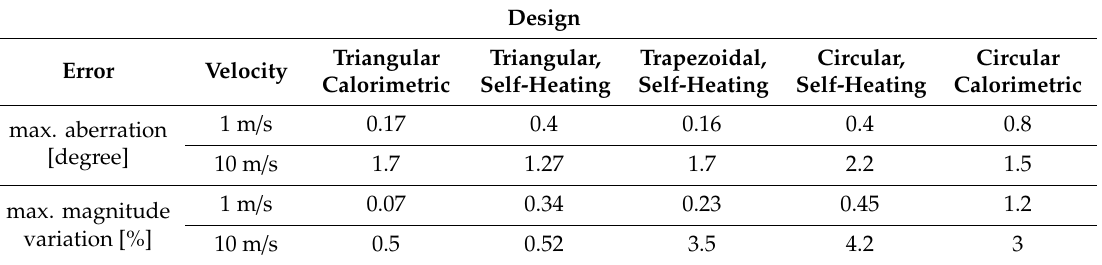
calculated using 𝜑𝜑